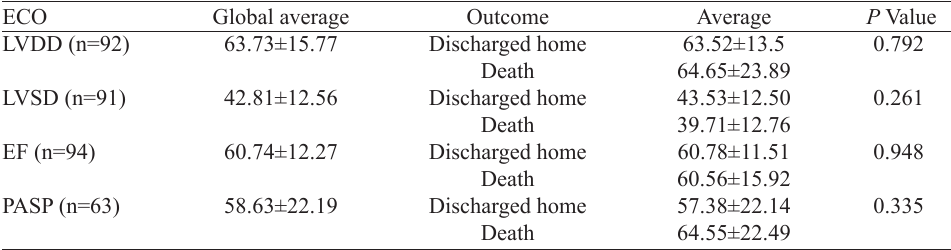
Death LVDD=Left Ventricular Diastolic Diameter; LVSD=Left Ventricular Systolic Diameter; EF=Ejection Fraction; ECO=Echocardiographic Measurements; PASP=Pulmonary Artery Systolic Table 3. Clinical and epidemiological characteristics and comparison between groups of hospital outcome. Variable